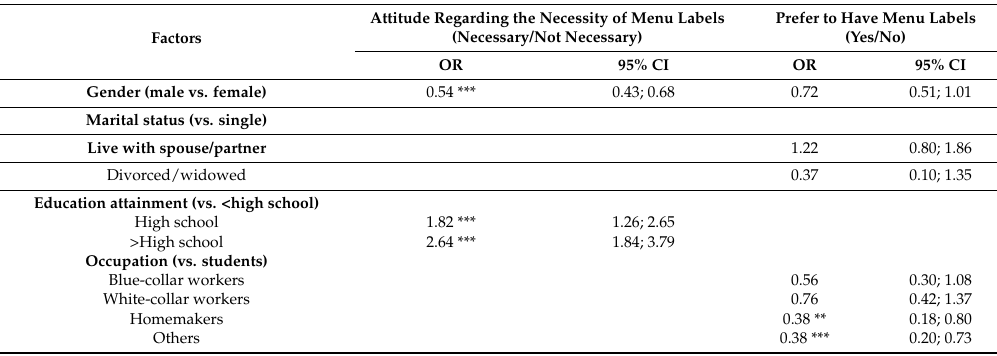
Prefer to Have Menu Labels (Yes/No)